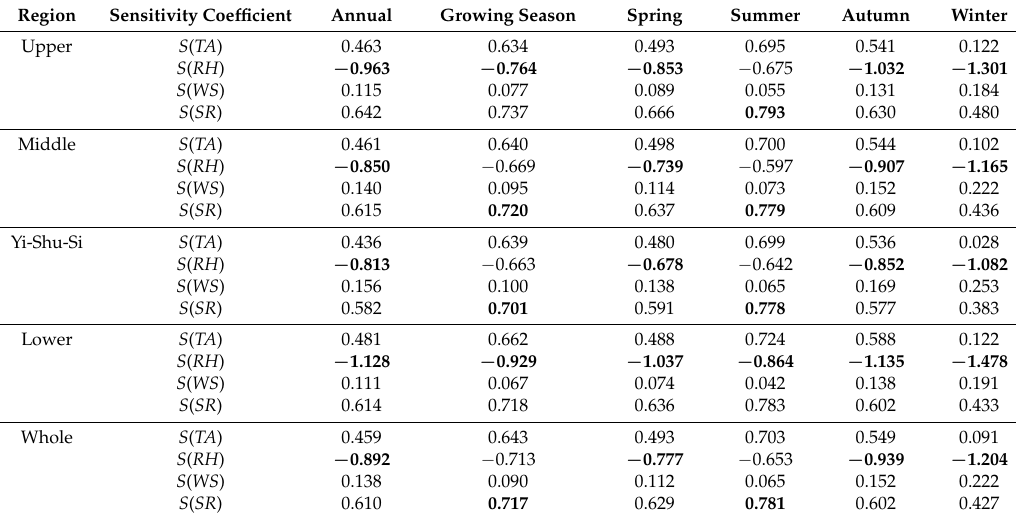
Table 3. Annual and seasonal sensitivity coefficients of ET ref to the main climate factors in each region of the HRB during 1961–2014.